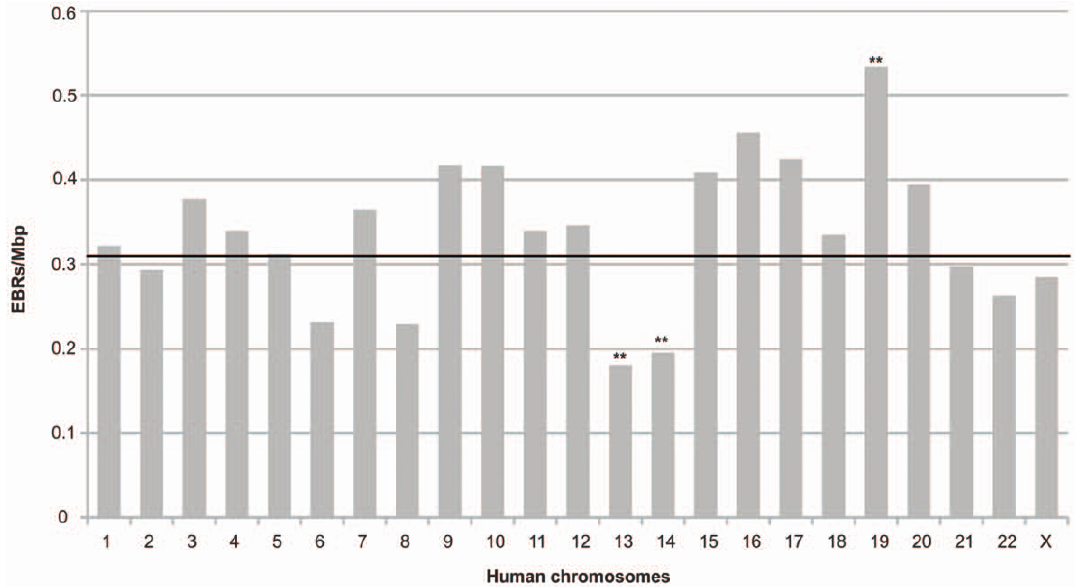
Figure 2. Distribution of EBRs across the human genome. Frequency of EBRs per megabase pair (Mbp) detected on each human chromosome. The dotted line represents the estimated frequency of EBRs per Mbp in the human genome.